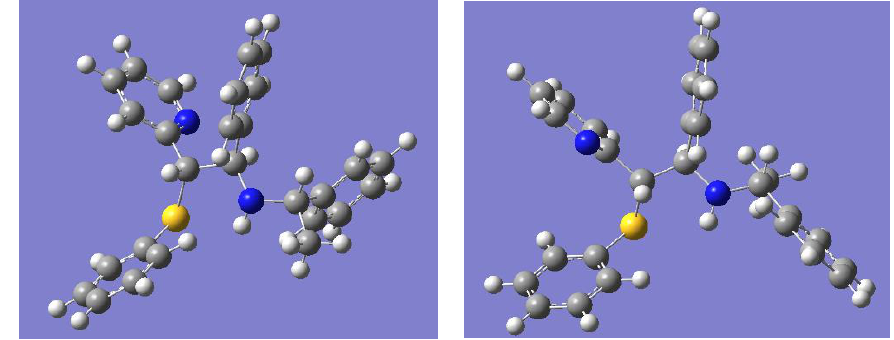
Figure 2. Molecular geometry of lowest energy structures optimized at the DFT/B3LYP/CC-pVDZ level for (4 R ,5 R , 1′ S )- 13 (left) and (4 S ,5S,1′ S )- 13 (right).